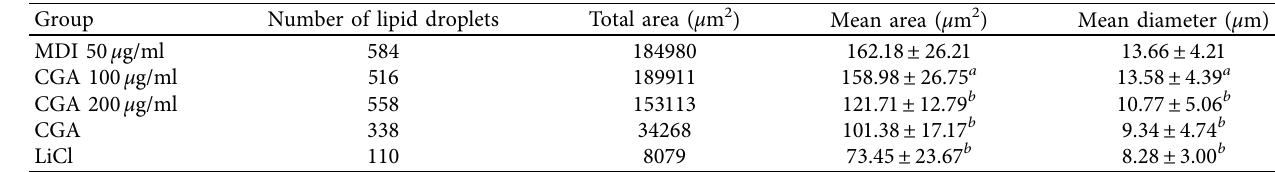
Table 2: Parameters of lipid droplets (mean ± SEM).